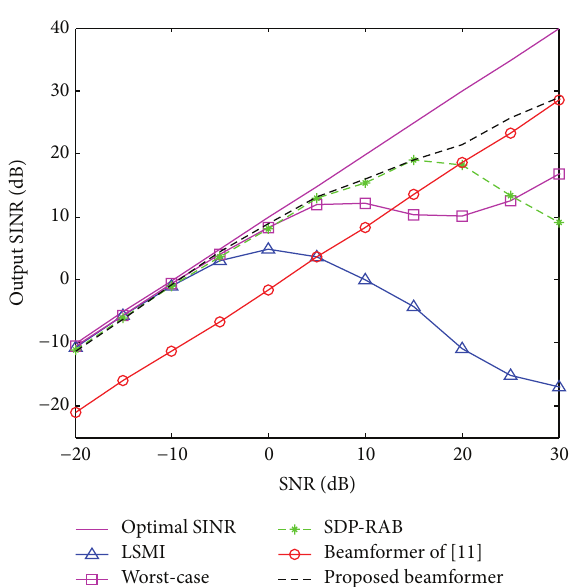
output SINRs versus input SNR for INR = 30 dB, and Figure 21 shows the output SINRs versus input SNRs for INR = 40